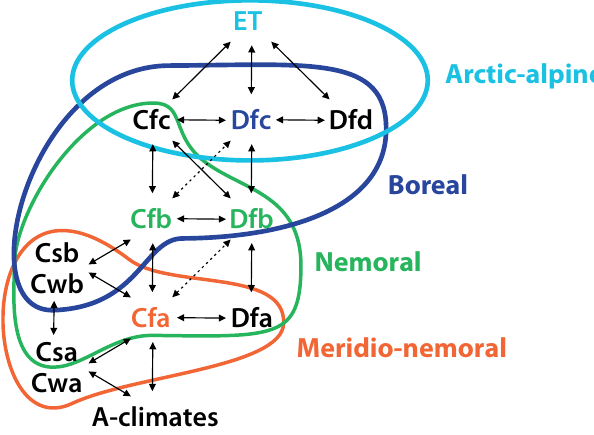
Fig. 2. Circumscription of meridio-nemoral, nemoral, boreal and Arctic–alpine elements by Köppen climate types (see also Table